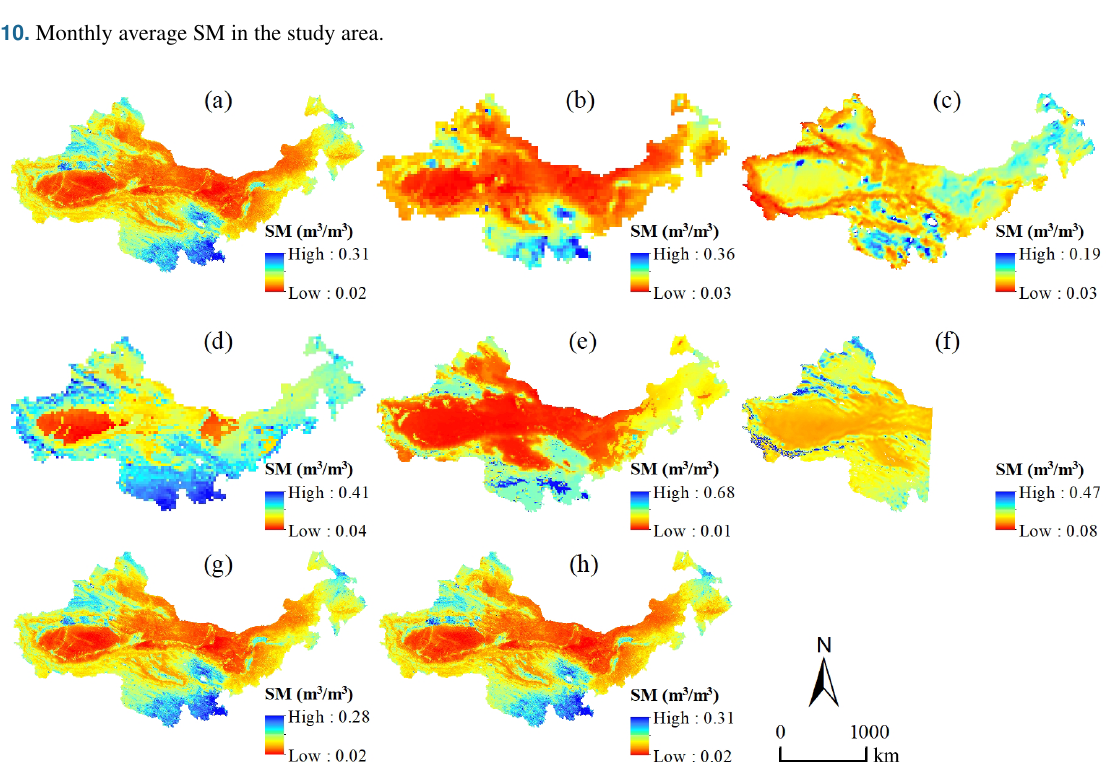
Figure 11. Daily average SM from 2015–2020 in the study area. Panels (a) – (h) are the downscaled SM (1km), SMAP L3 SM (36km), GCOMW/ASMR2 SM (0.1 ◦ ), C3S SM (0.25 ◦ ), ERA5 SM (0.1 ◦ ), FLDAS SM (0.1 ◦ ), and RF-based and XGB-based downscaled SM (1km),